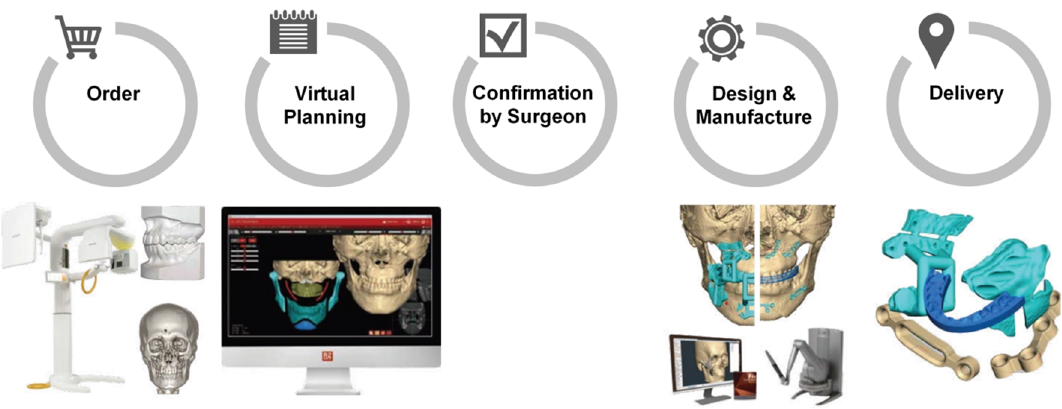
Figure 1. Work process of orthognathic surgery with the computer-aided surgical simulation (CASS) system using FaceGide ® [11].